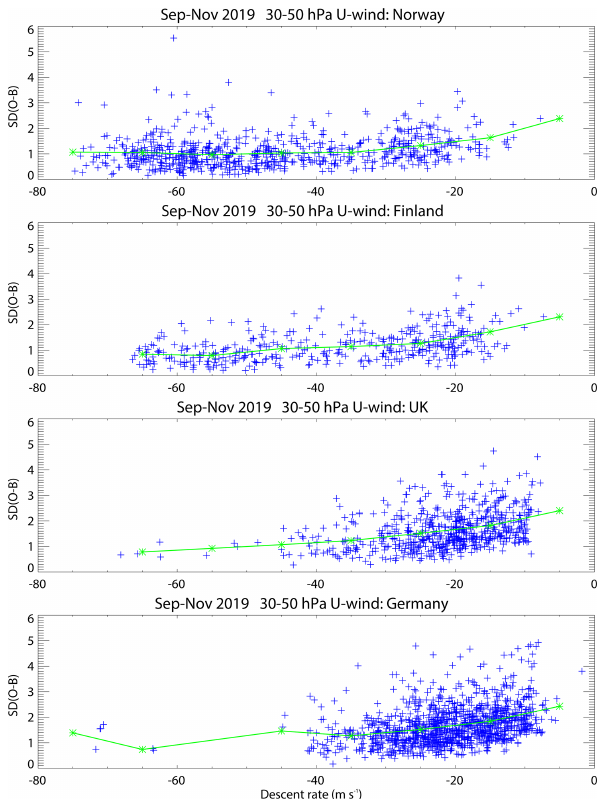
Figure 12. The standard deviation of O − B plotted against the mean descent rate, both for descents from 30 to 50hPa (blue sym- bols). The green symbols show the average values for bins of 10ms − 1 .